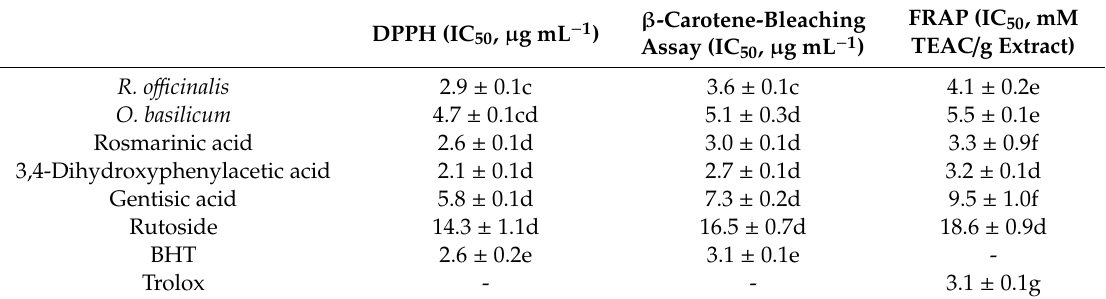
Table 2. 2,2-diphenyl-1-picrylhydrazyl (DPPH), β -Carotene bleaching and ferric reducing antioxidant power (FRAP) measures of R. officinalis and O. basilicum leaf extracts, rosmarininic acid, 3,4-dihydroxyphenylacetic acid, gentisic acid, and rutoside.